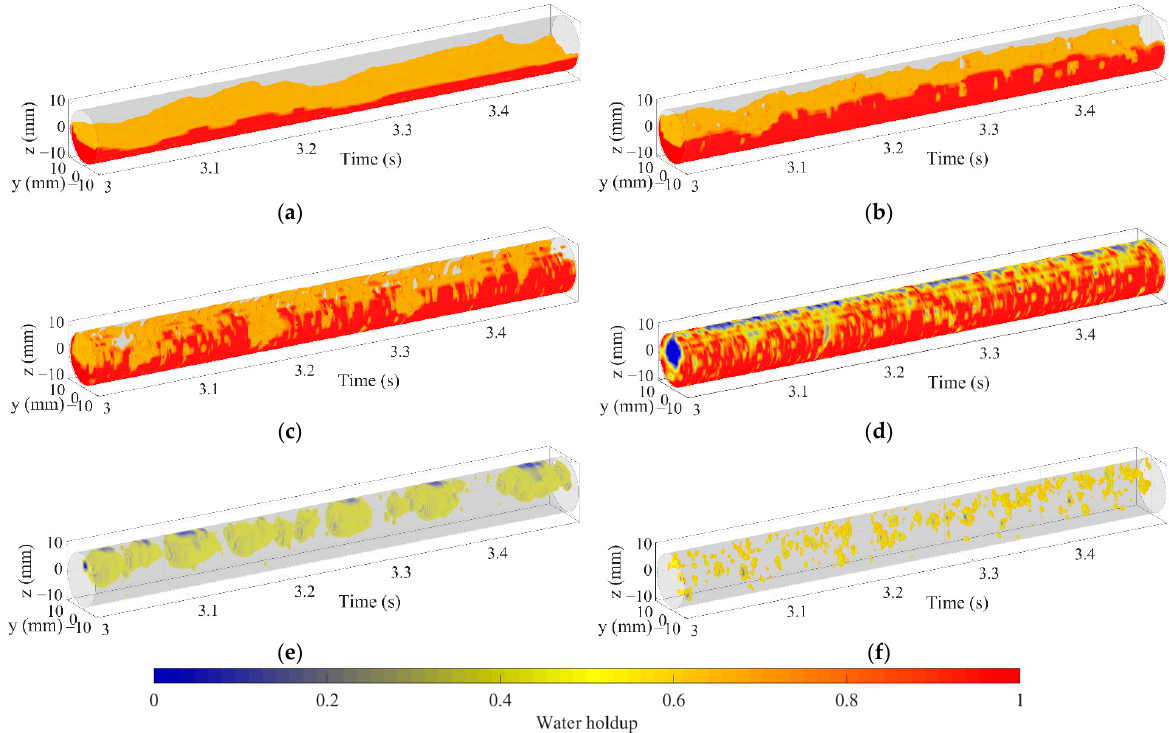
Figure 12. The 3D flow visualization for different oil–water flow patterns (0°): ( a ) U sw = 0.184 m/s, U so = 0.162 m/s, ST; ( b ) U sw = 0.368 m/s, U so = 0.236 m/s, ST&MI; ( c ) U sw = 0.737 m/s, U so = 0.552 m/s, D W/O&D O/W; ( d ) U sw = 1.105 m/s, U so = 0.552 m/s, D W/O&D O/W WF; ( e ) U sw = 1.105 m/s, U so = 0.106 m/s, D OS &W; ( f ) U sw = 1.67 m/s, U so = 0.236 m/s, D O/W.